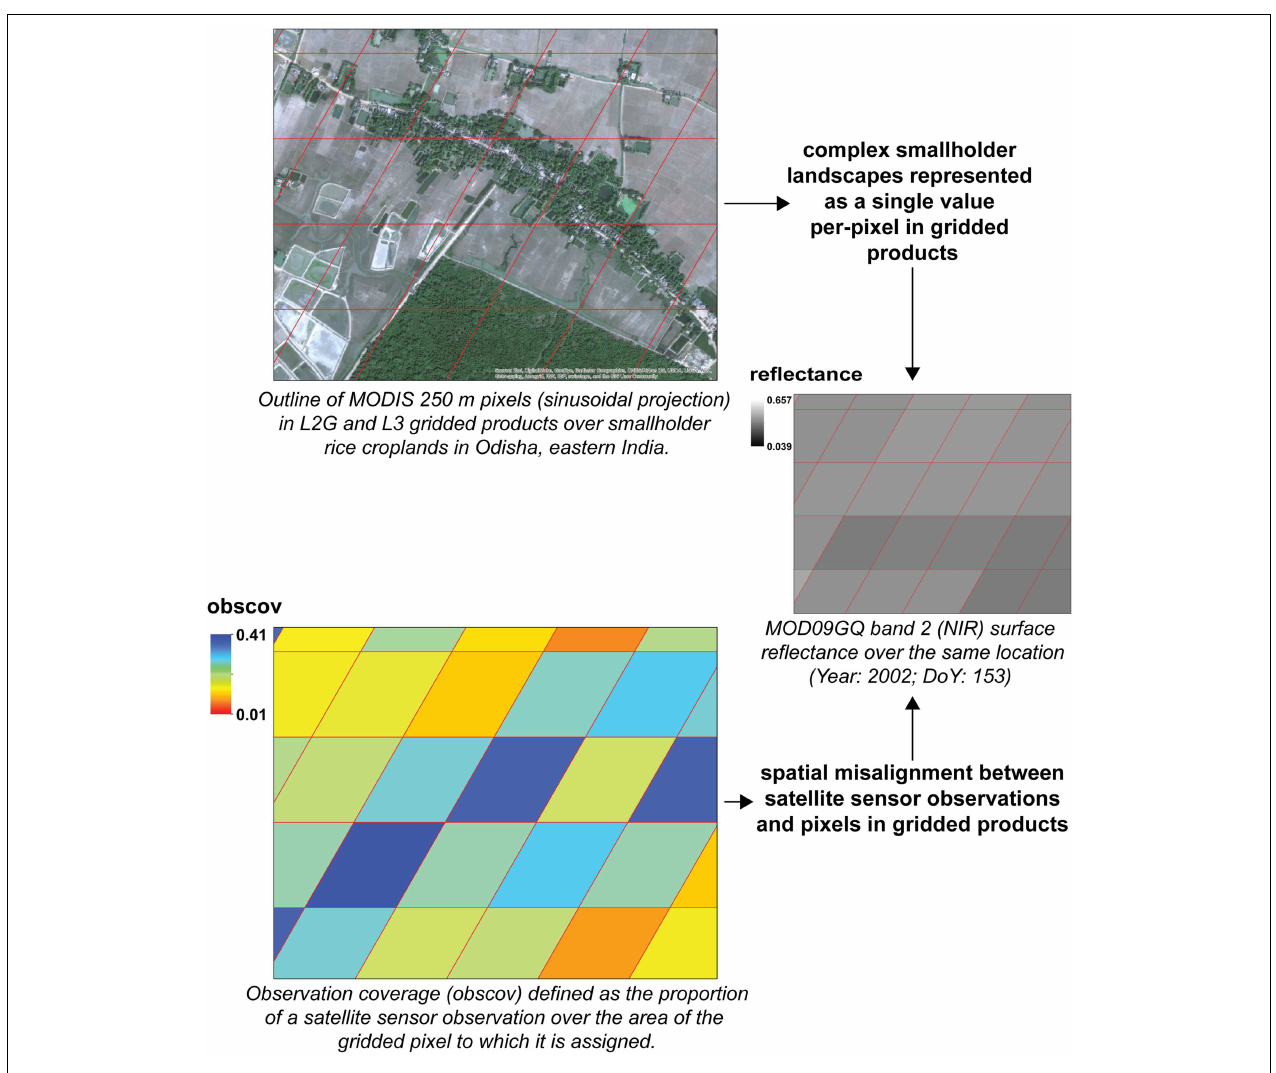
coverage (obscov) values for the same grid cells. This image corresponds to smallholder croplands near the Bhitarkanika mangrove forests in Odisha, India (Sources: Esri, DigitalGlobe, GeoEye, i-cubed, Earthstar Geographics, CNES/Airbus DS, USDA, USGS, AEX, Getmapping, Aerogrid, IGN, IGP, swisstopo, and the GIS User